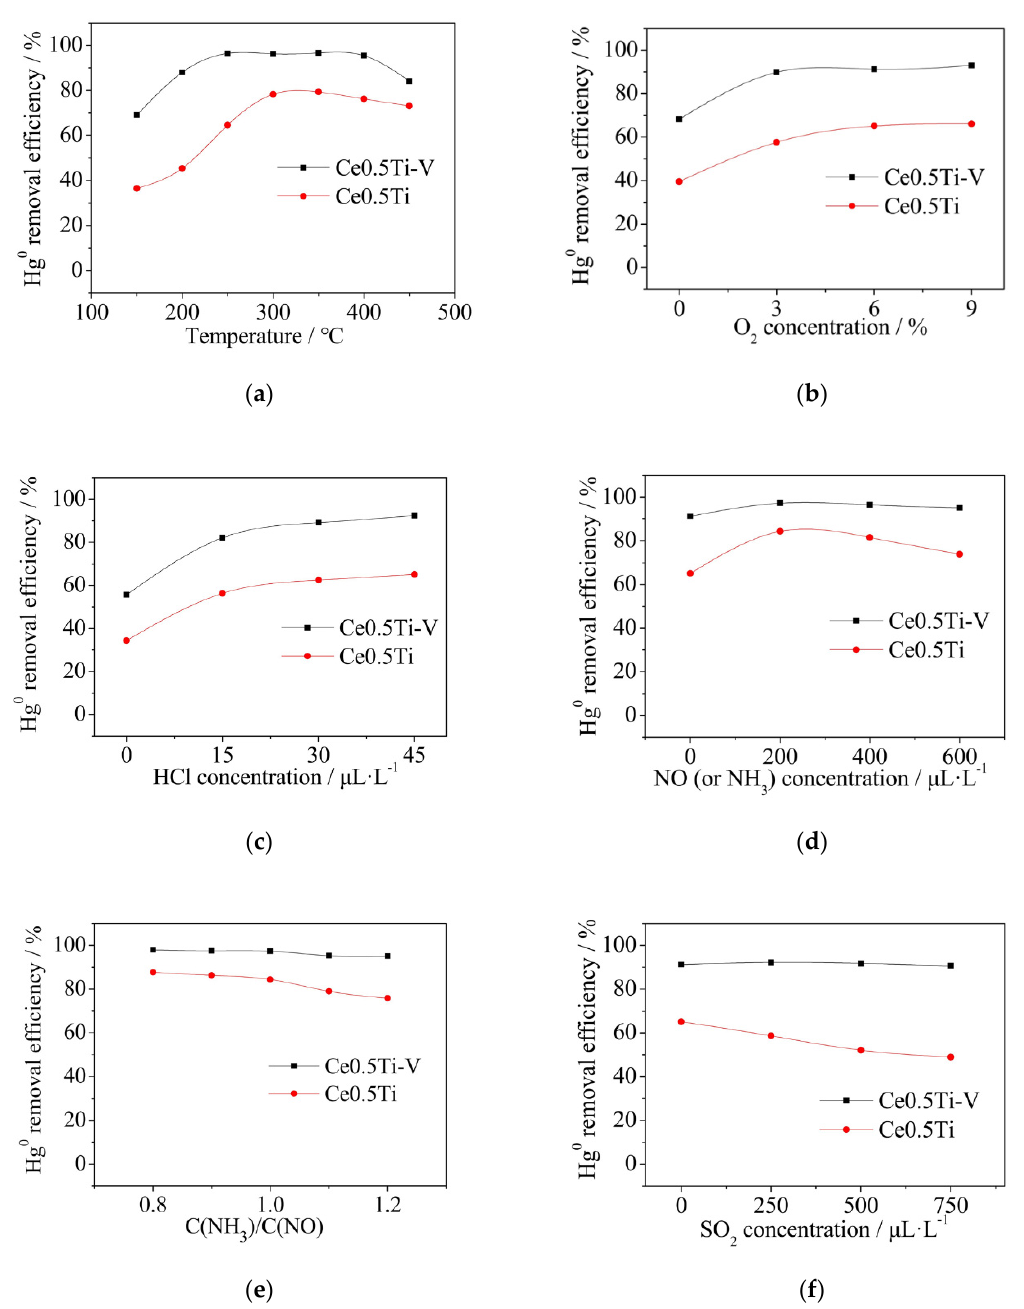
Figure 5. Catalytic performance after the addition of vanadium; ( a ) the effect of temperature; ( b ) the e ff ect of O 2 ; ( c ) the e ff ect of HCl; ( d ) the e ff ect of NO and NH 3 ; ( e ) the e ff ect of the ratio of NH 3 / NO; effect of O 2 ; ( c ) the effect of HCl; ( d ) the effect of NO and NH 3 ; ( e ) the effect of the ratio of NH 3 /NO; ( f ) the e ff ect of SO 2 ( f ) the effect of SO 2 .